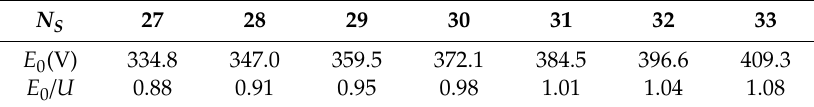
Table 4. No-load, back-induced EMF ( E 0 ) with di ff erent N S